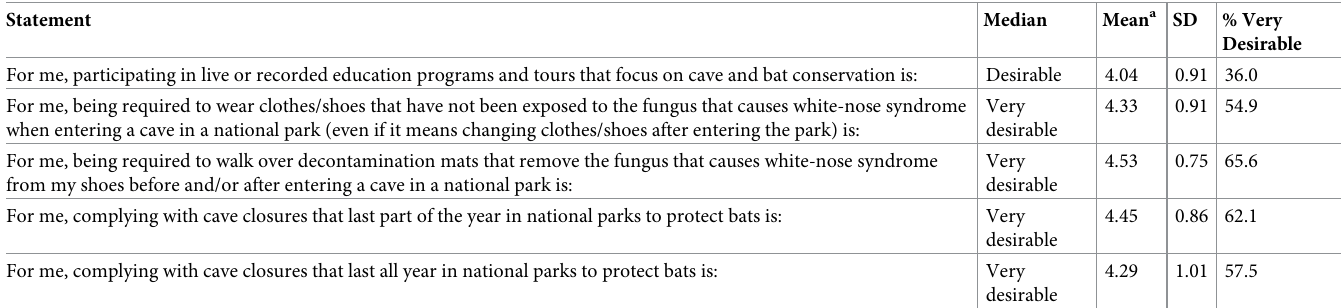
Table 2. Visitor attitudes about white-nose syndrome preventive actions used by the U.S. National Park Service, 2019.